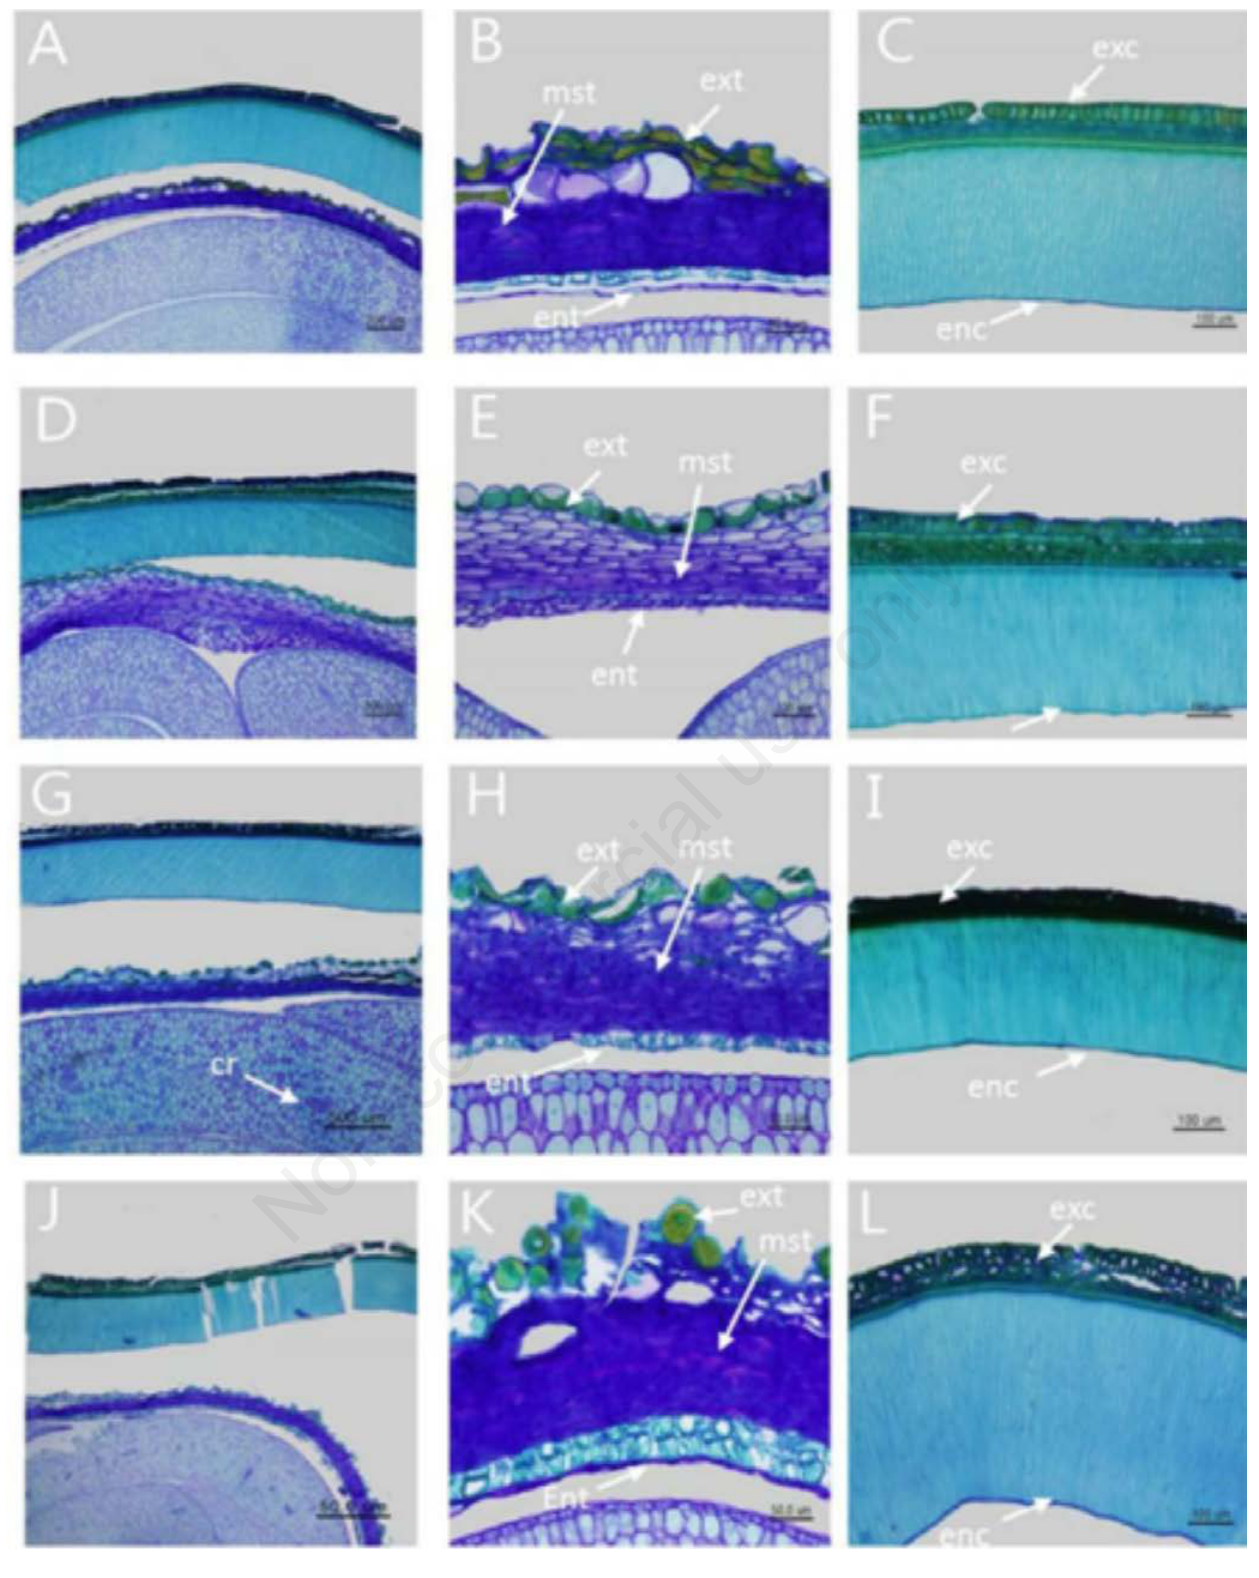
Figure 5. Seed anatomy of Calycanthaceae. A-C, Chimonanthus fragrans ; D-F, Chimonanthus salicifolius ; G-I, Chimonanthus yunna- nensis ; J-L, Chimonanthus luteus . Abbreviation: ent, endotesta; ext, exotesta; mst, mesotesta; exc, exocarp; enc, endocarp; cr, crystal